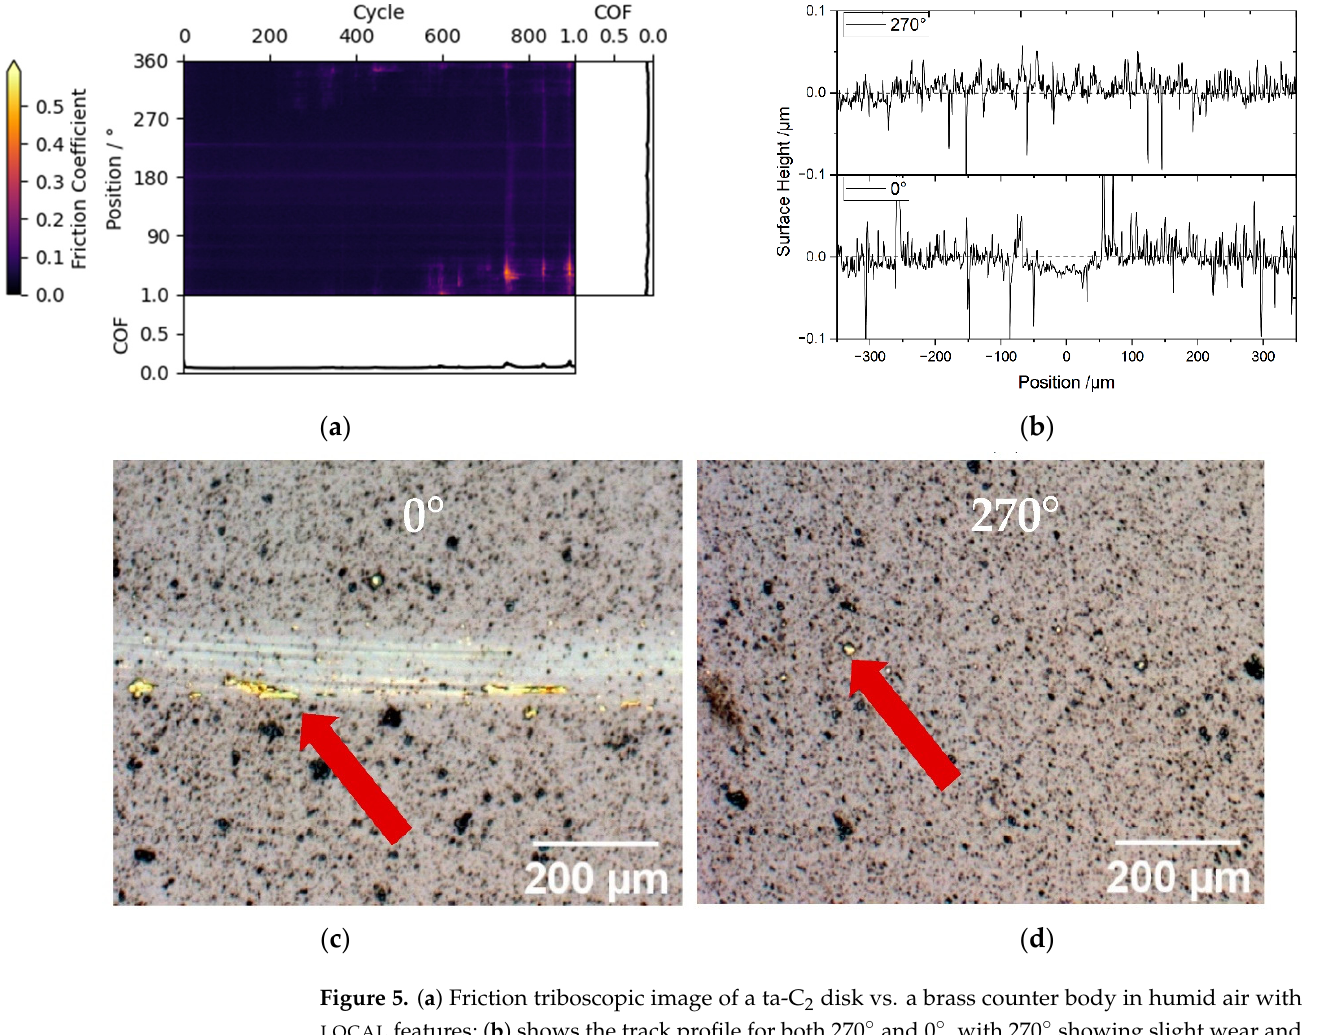
Figure 5. ( a ) Friction triboscopic image of a ta-C 2 disk vs. a brass counter body in humid air with LOCAL features; ( b ) shows the track profile for both 270° and 0°, with 270° showing slight wear and 0° showing no wear; ( c , d ) wear track micrographs of experiments: ( c ) 0° position; ( d ) 270° position, with exemplary spots of brass highlighted with red arrows. The transferred brass is clearly visible in the first wear track, where the track is measurably worn, indicating a correlation between brass transfer and subsequent carbon coating wear.